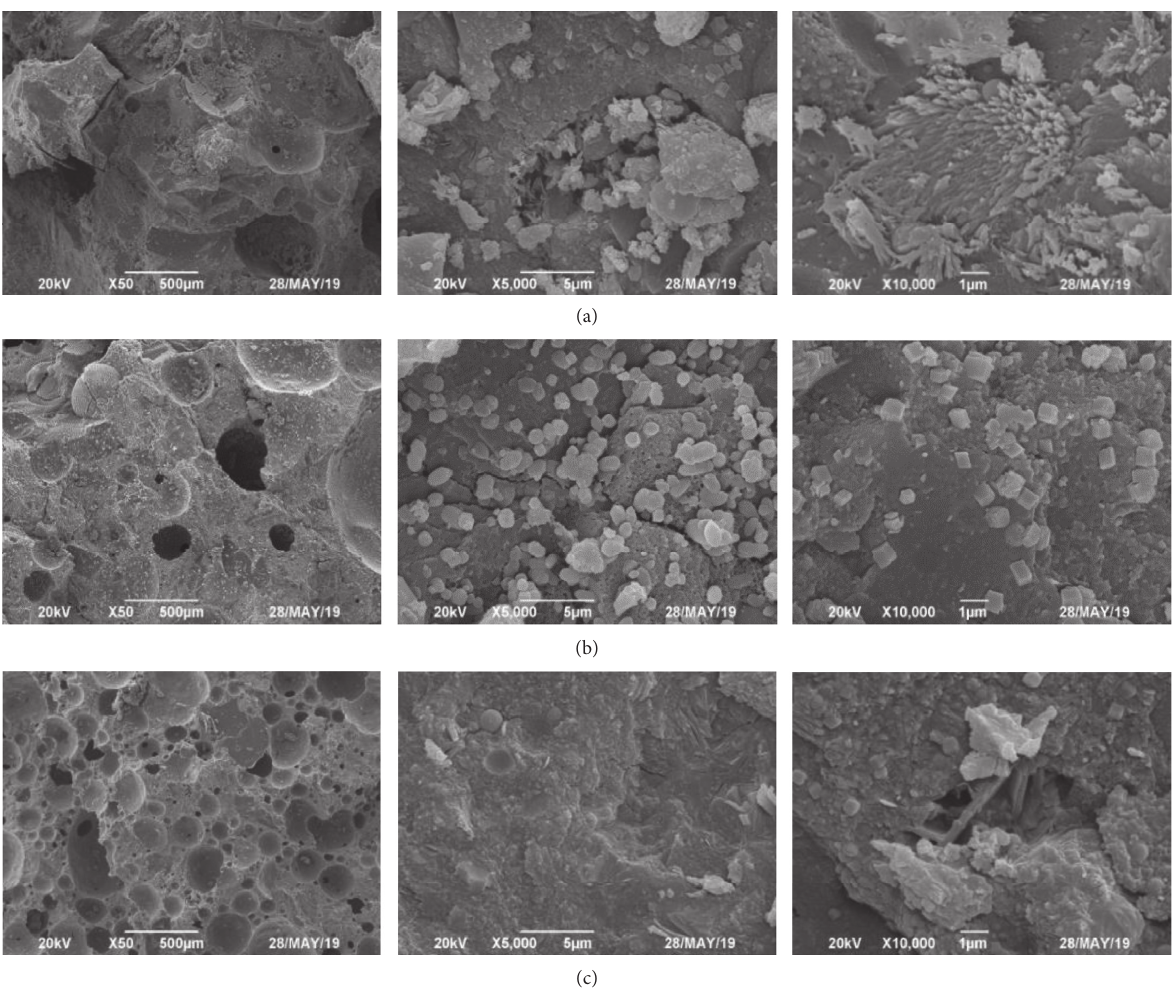
Figure 7: FC microstructures under SEM: (a) 5% SF; (b) 15% SF; (c) 25% SF.